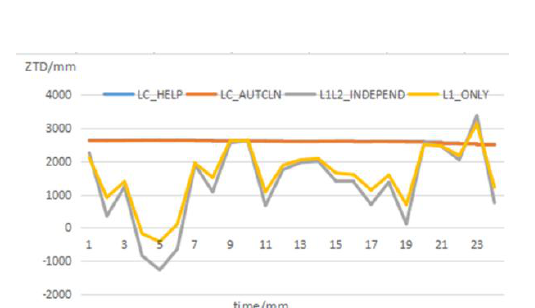
Figure 3. ZTD comparative